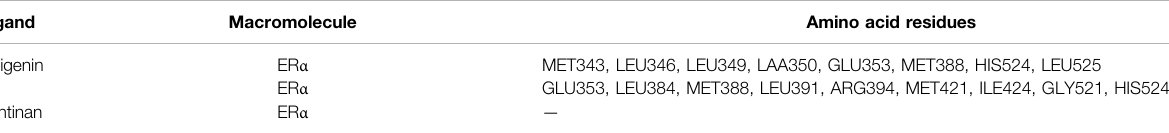
TABLE 1 | Amino acid residues in the apigenin, E2, and lentinan binding sites of ER α .